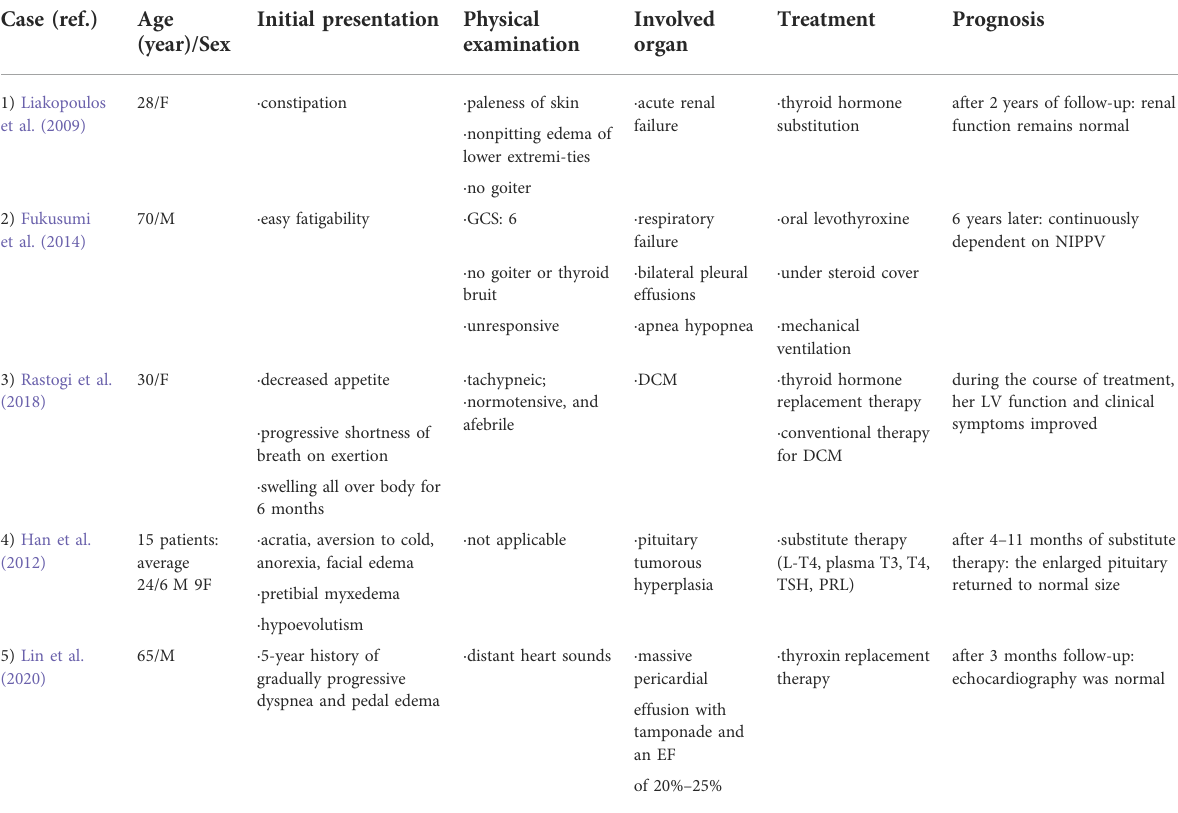
TABLE 3 Clinical features of cases regarding severe hypothyroidism. Case (ref.)